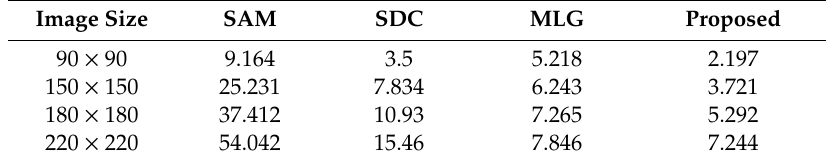
Table 2. Average runtime (s) of various methods on di ff erent images at 1 GHz, 3 GHz, and 6